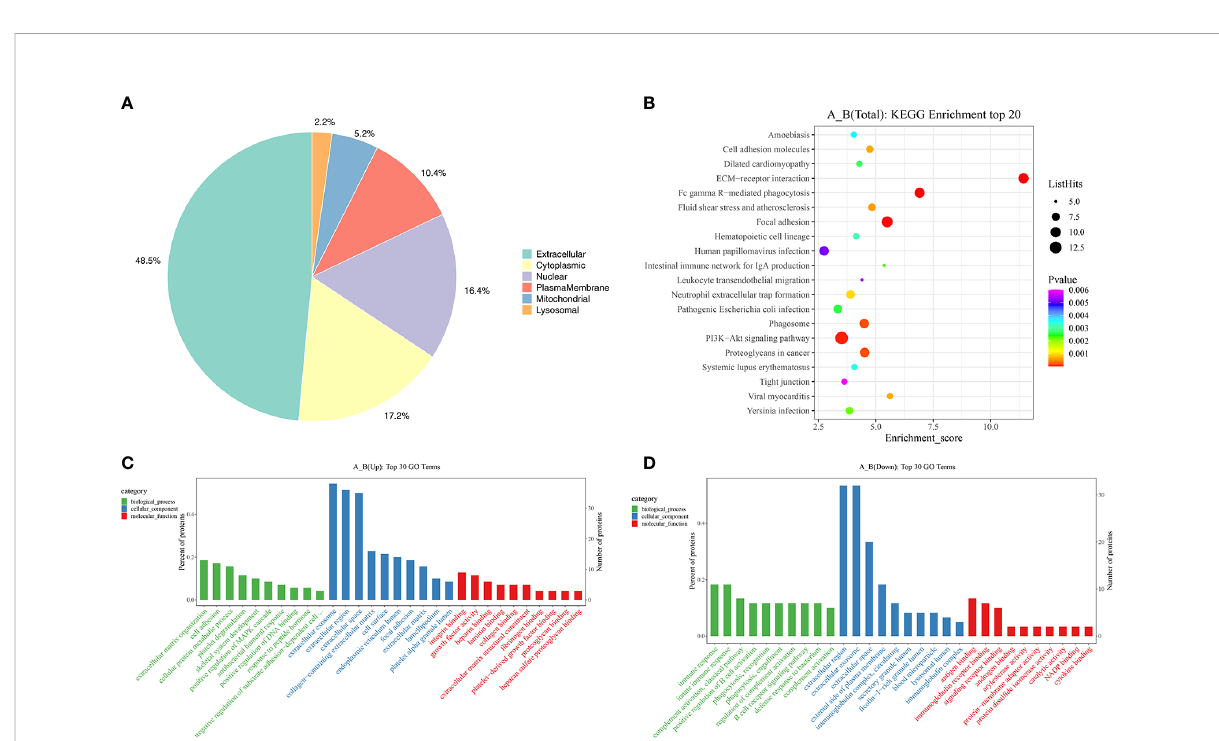
FIGURE 2 Subcellular localization and functional enrichment analysis of differentially expressed proteins. (A) Subcellular localization of the differentially expressed proteins. (C) GO terms of the differentially expressed proteins in the up-regulated group. (D) GO terms of the differentially expressed proteins in the down-regulated group. (B) The top 20 bubbles of KEGG enrichment in the differentially expressed proteins.